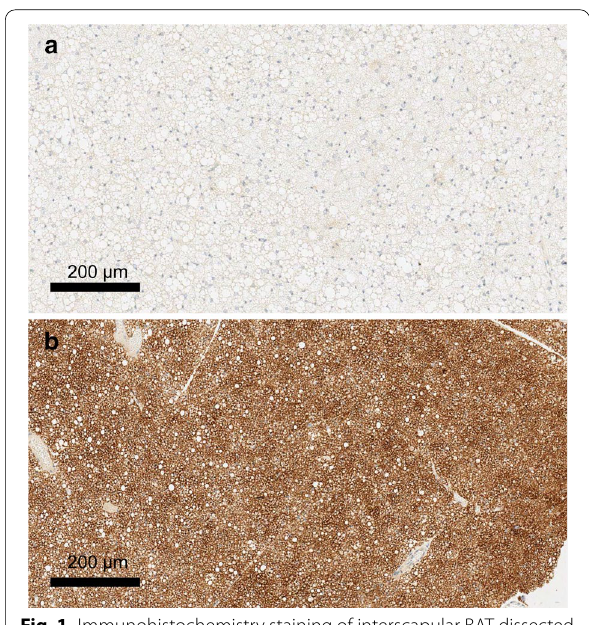
Fig. 1 Immunohistochemistry staining of interscapular BAT dissected from WT and KO mice. a KO, b WT genotypes within breeding colonies were validated with UCP1 staining of dissected interscapular BAT. Slides are shown at 50% zoom. The lack of protein in our KO mice was confirmed, and UCP1 was strongly expressed in the BAT cells of our WT mice